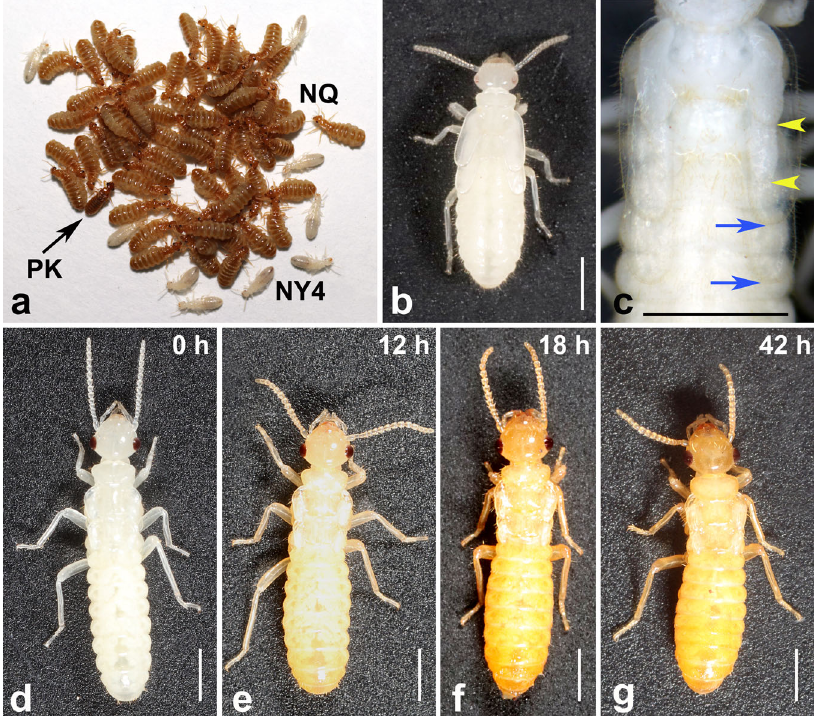
Fig. 2 Development and maturation of neotenic queens in E. neotenicus . a Primary king (PK) accompanied by a group of mature neotenic queens (NQ) and female nymphs (NY4). b NY4 ♀ from a non-dispersing colony. c Pharate neotenic queen before shedding the cuticle of NY4 ♀ . The tips of wing rudiments of future NQ are marked with arrowheads, tips of NY4 ♀ wing pads are marked with arrows. Scale bar indicates 1 mm. d – g Neotenic queen 0, 12, 18, and 42 h after molting from NY4 ♀ While in solvent controls 8 (17.7%) and 9 (20%) new NQs III with colonies H and I. The general design was identical to developed during 60 h in colony H and I respectively, only a Experiment II (Fig. 5a). Termite groups were exposed for 60 h to single NQ was retrieved in the 10NQ and 10QE# treatments three treatments, i.e., solvent control, 10 live mature NQs (10NQ) (2.2%) in each colony (Fig. 5b, e). Survival curves of cumulative and 10 queen headspace equivalents of RNERO loaded on a piece of fi lter paper surrounded with a fi ne double mesh, preventing, in this counts of new NQs were signi fi cantly different in both colonies (colony H: χ 2 = 10.96, df = 2, p = 4.2 × 10 − 3 , Fig. 5b; colony I: case, the direct contact of the termites with the paper (10QE#).